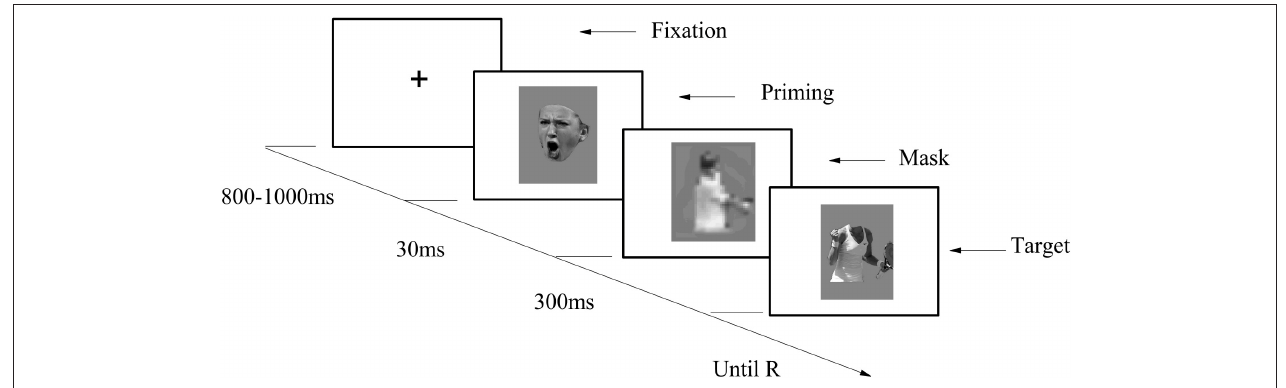
FIGURE 4 | Procedure of Experiment